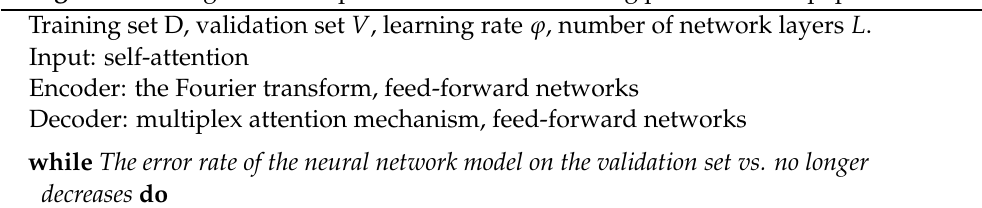
Algorithm 1: Algorithmic representation of the training process in this paper. Training set D, validation set V , learning rate ϕ , number of network layers L